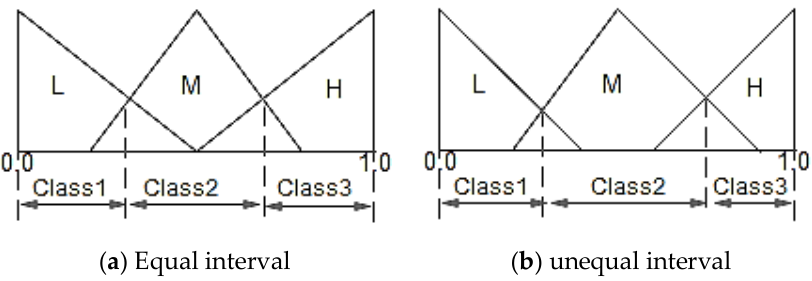
Figure 9. Membership linguistic variables boundaries without CF.